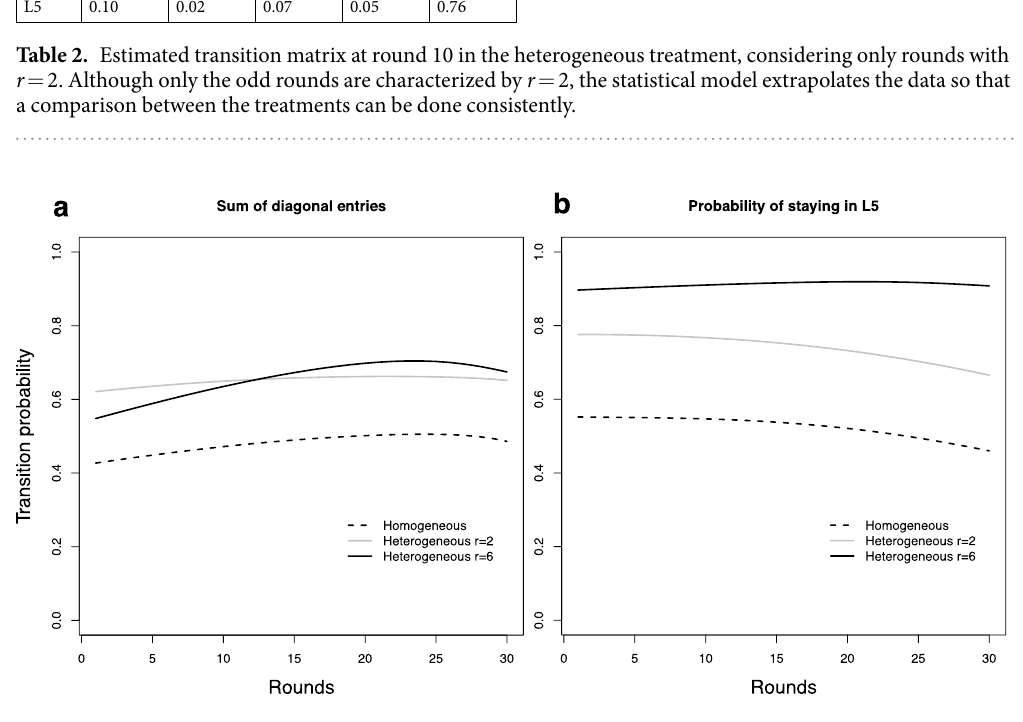
Figure 4. Time evolution of estimated transition probabilities. The sum of the probabilities of staying in the same state is shown in ( a ). In general, individuals in the heterogeneous treatment are more conservative. The time evolution of the probability of continuing to contribute all tokens is shown in ( b ). Notice that, for r = 2 in the heterogeneous treatment, high contributors tend to keep contributing all